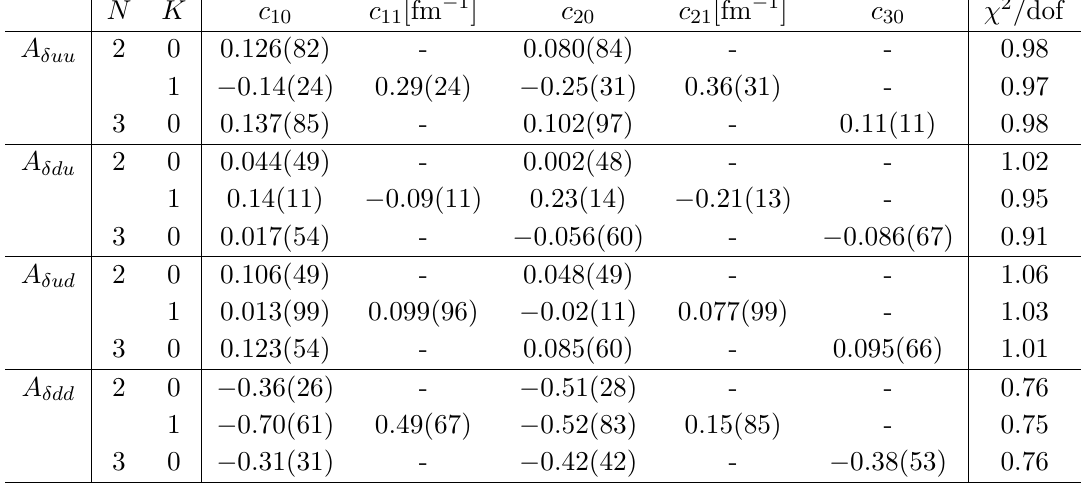
Table 9 . The same as table 7, but for the twist-two function A δqq 0 .